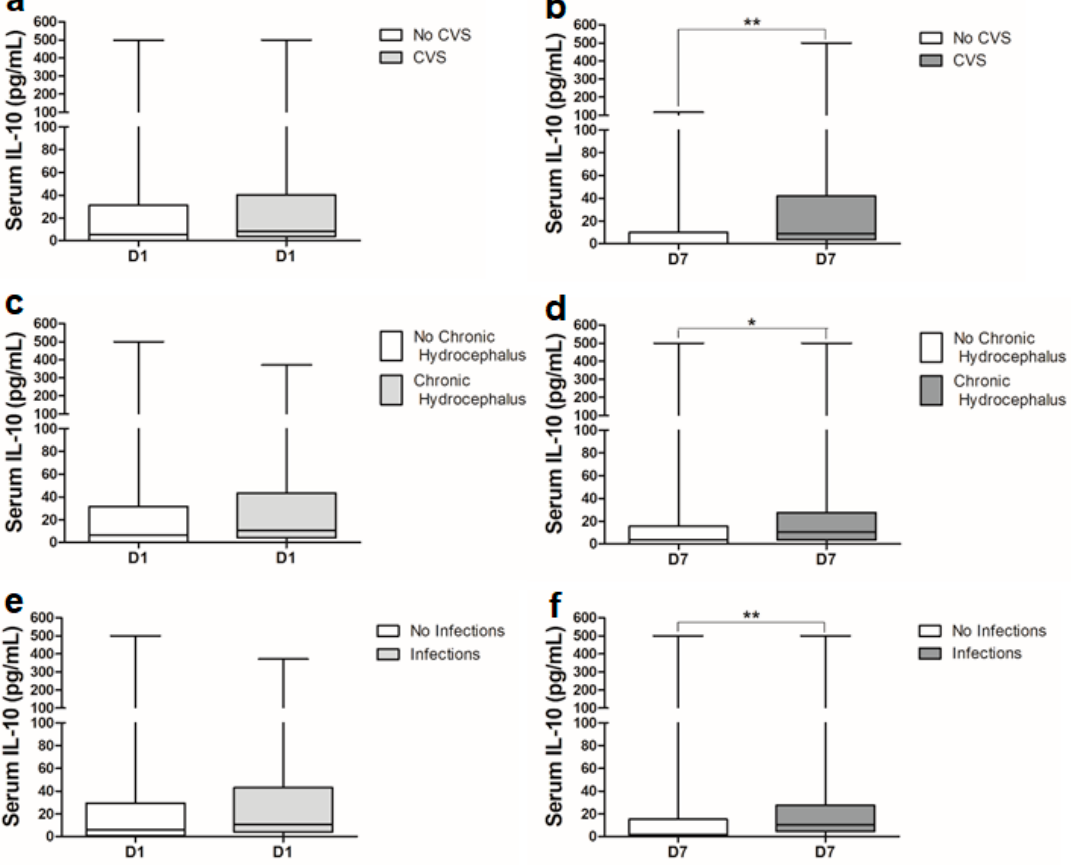
Figure 3. Comparison of serum IL-10 levels between SAH patients with: ( a ) no CVS ( n = 32) and CVS ( n = 44) on day 1; ( b ) no CVS ( n = 32) and CVS ( n = 44) on day 7; ( c ) no VP-shunt-dependent chronic hydrocephalus ( n = 53) and VP-shunt-dependent chronic hydrocephalus ( n = 23) on day 1; ( d ) no VP-shunt-dependent chronic hydrocephalus ( n = 53) and VP-shunt-dependent chronic hydrocephalus ( n = 23) on day 7; ( e ) no infections ( n = 49) and infections ( n = 27) on day 1; ( f ) no infections ( n = 49) and infections ( n = 27) on day 7. Mann–Whitney U test; p < 0.05 is significant (* p < 0.05; ** p <